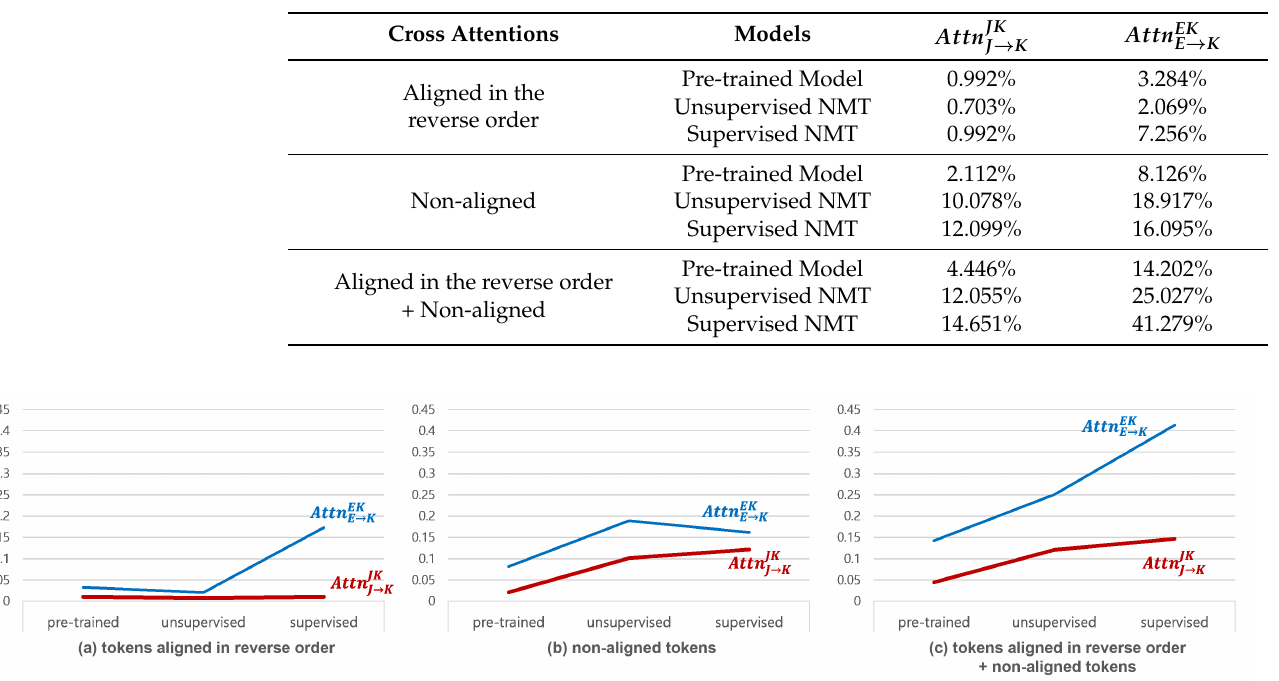
Table 7. The cross-attentions between Japanese–Korean and English–Korean.